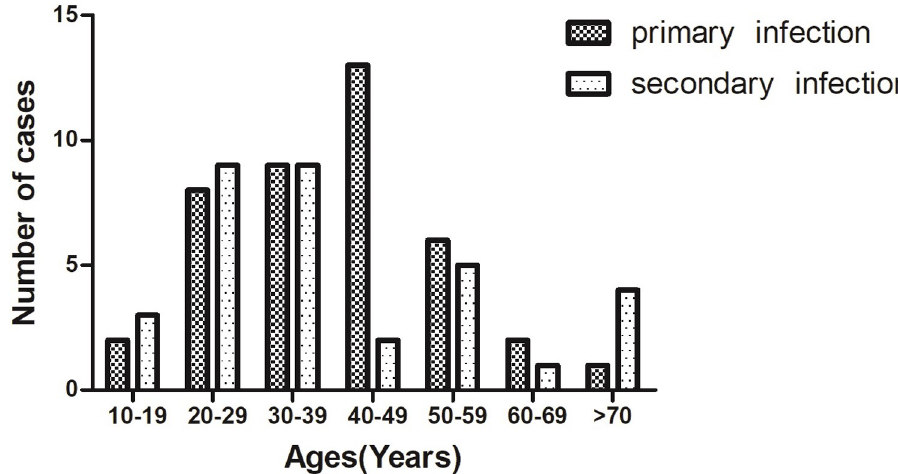
Fig 5. Distributions of primary and secondary DENV infections among patients in different age groups.